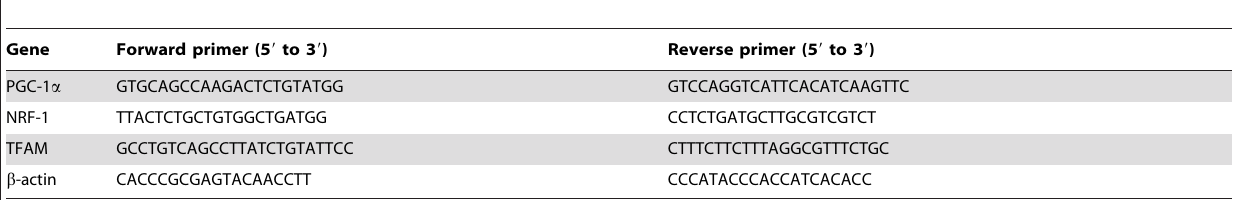
Table 2. RT-PCR primer